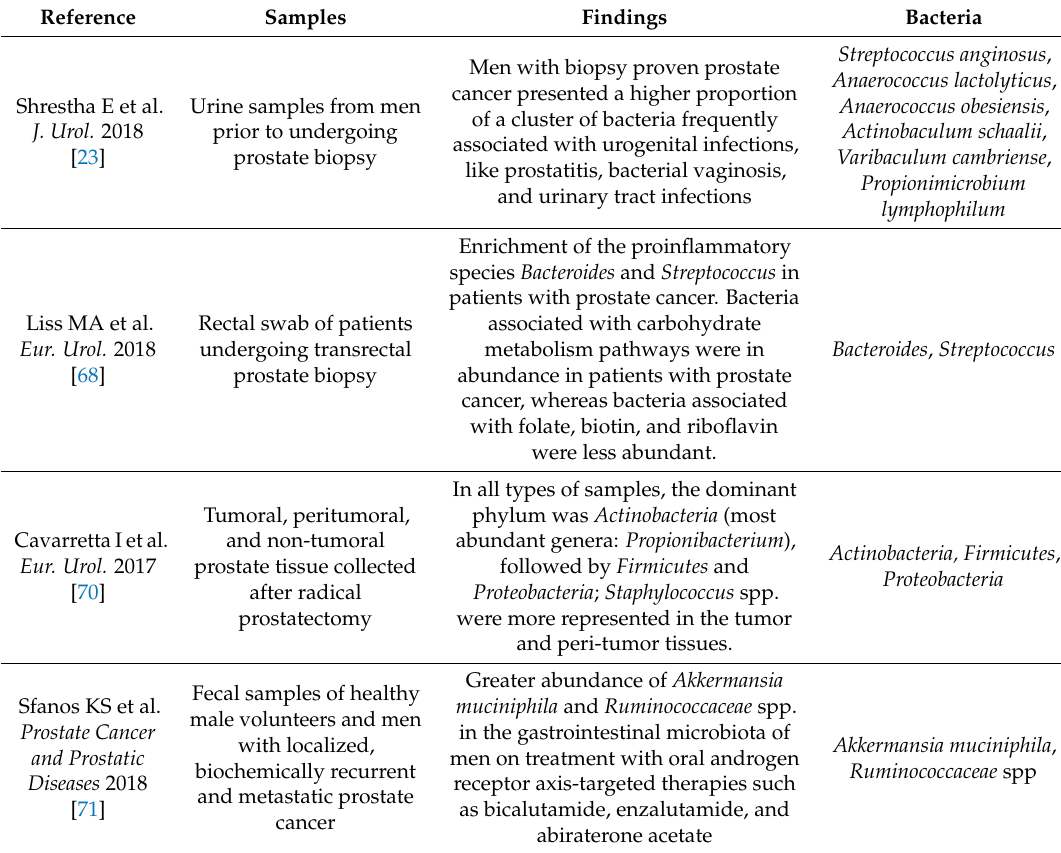
Table 1. Studies discussed in the manuscript investigating the connection between microbiota and prostate